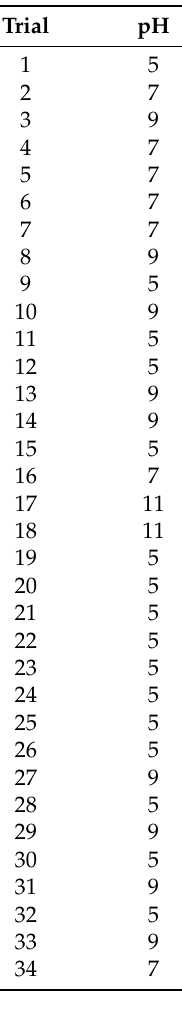
Table 1. Experimental conditions for each